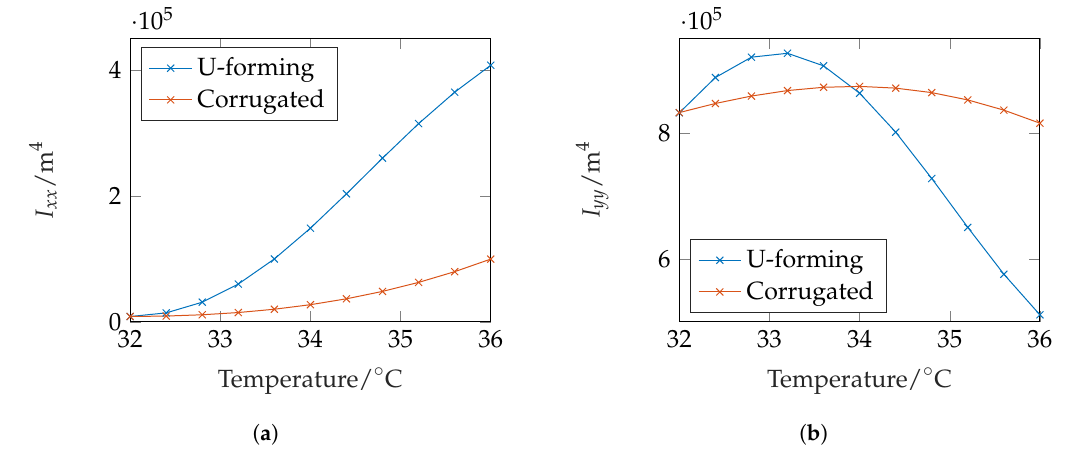
Figure 7. The swelling of the simple two-layer structure according to Figure 6a (U-forming) and the corrugated sheet structure (presented in Section 3.2) lead to a change in I xx and I yy . ( a ) Moment of inertia for bending around the x -axis. ( b ) Moment of inertia for bending around the y